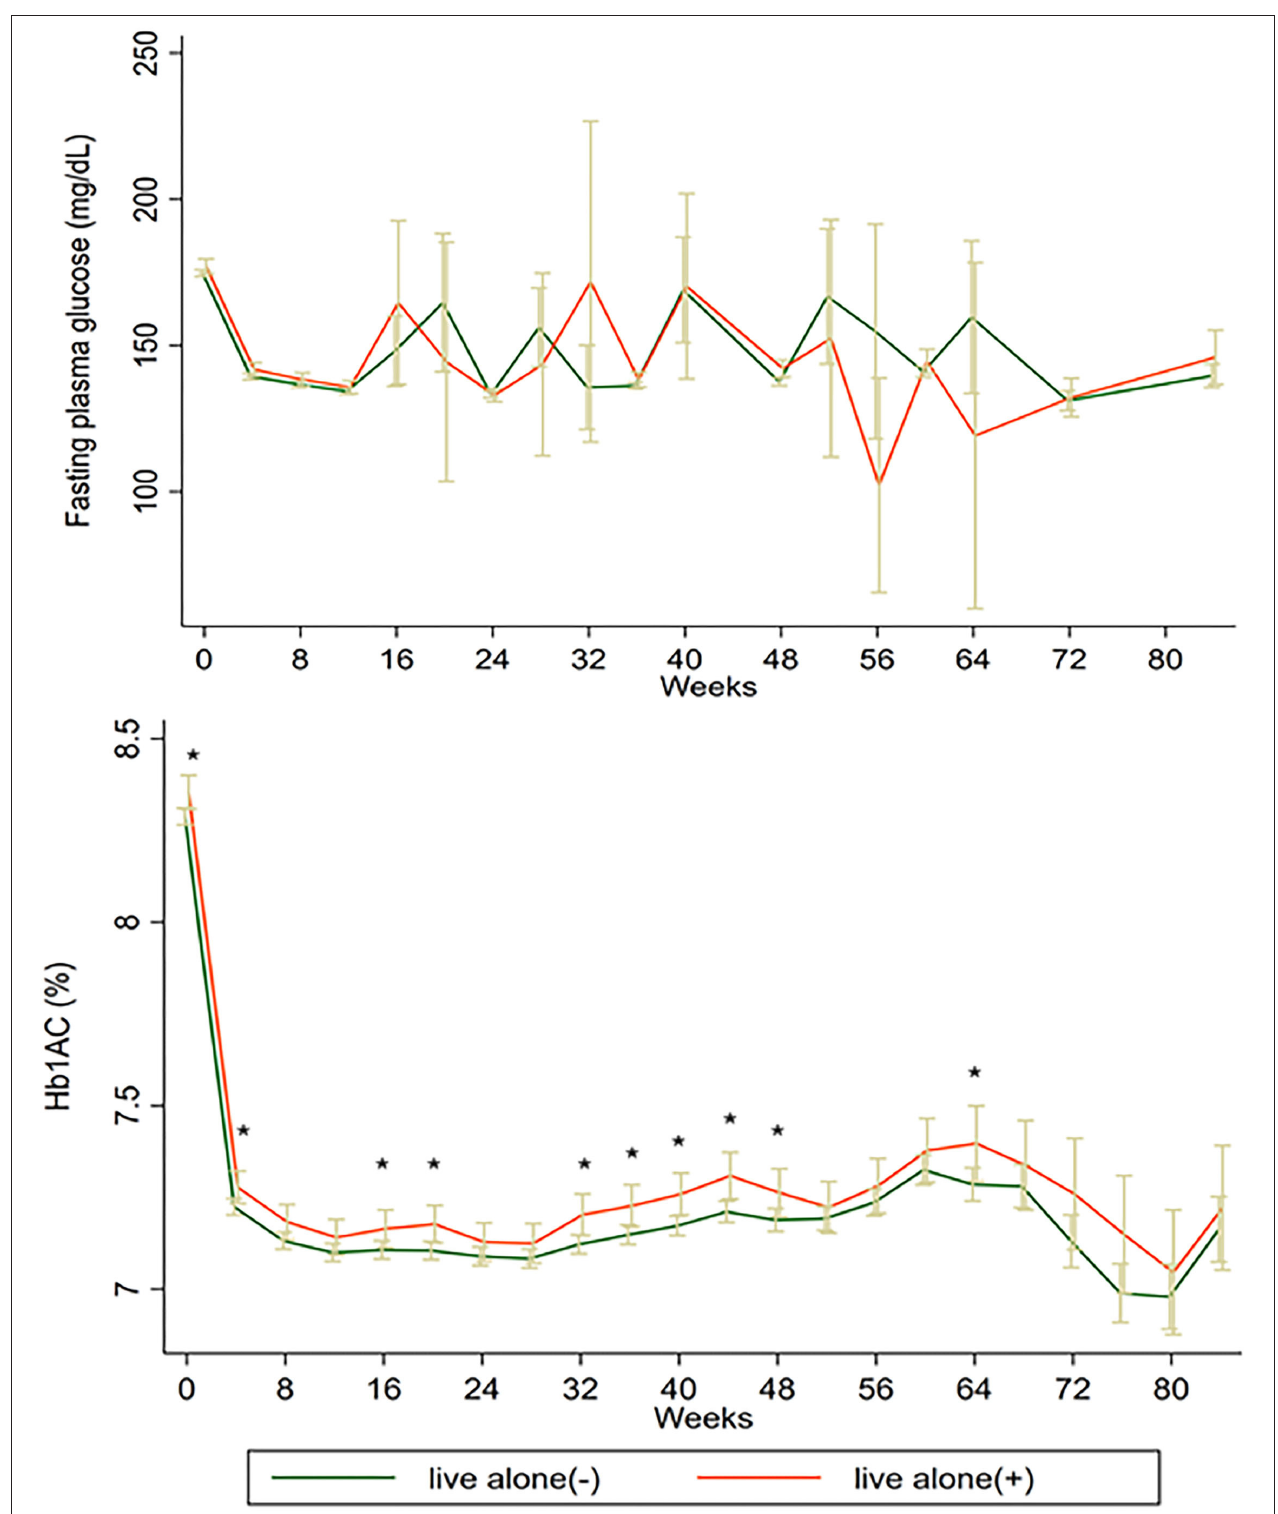
FIGURE 1 | The levels of FPG and HbA1C of participants living alone and living with others. FPG, fasting plasma glucose; HbA1C, glycated hemoglobin.